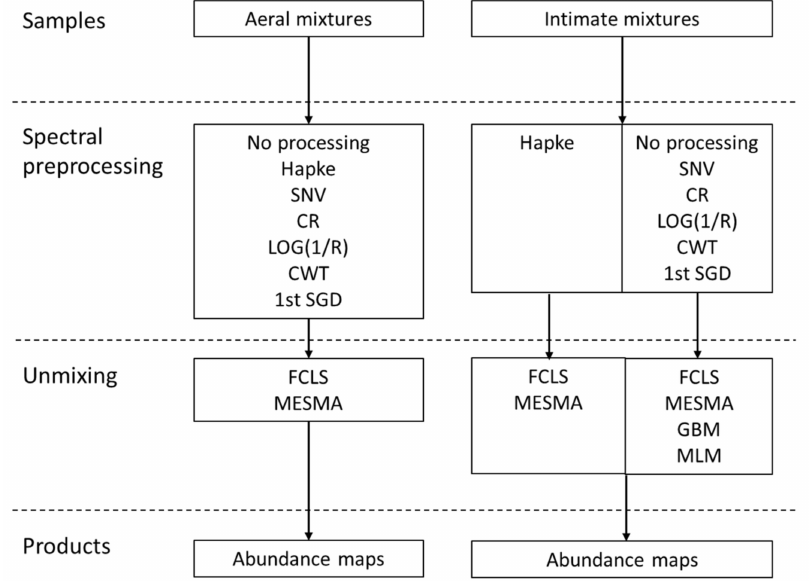
Figure 5. Processing chain to estimate montmorillonite abundance. Linear unmixing performances on aeral mixtures are compared with linear and nonlinear unmixing